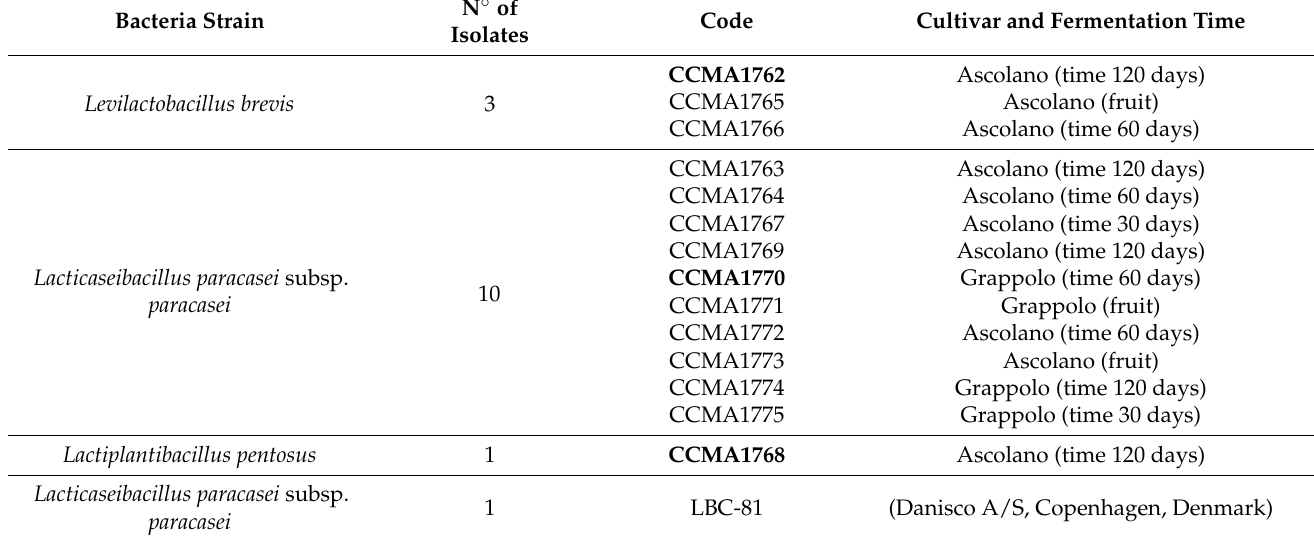
Table 1. Bacteria strains from table olives used in this study ( n =